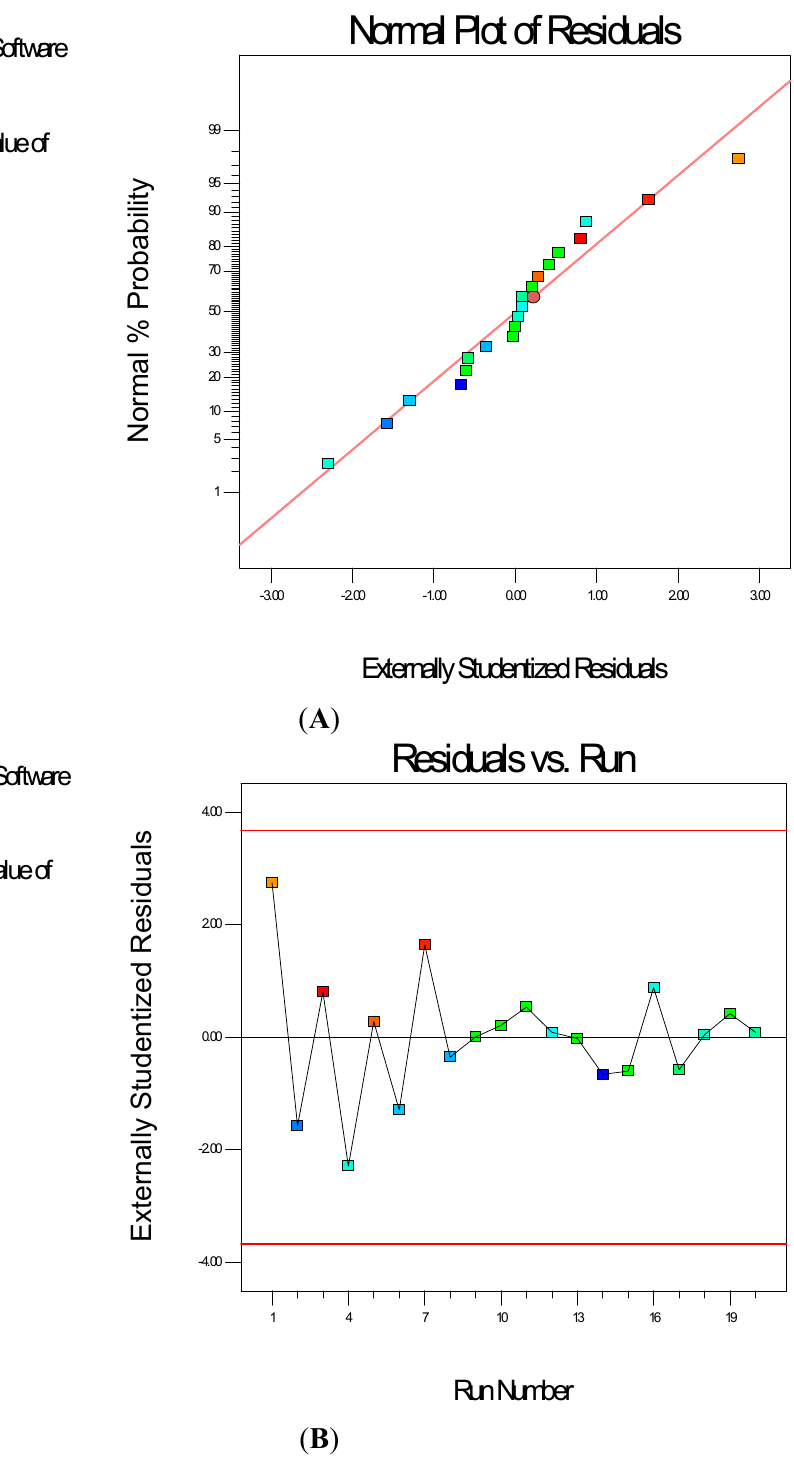
Figure 4. Diagnostic plots the percent yield data of Polylactide-based nanoparticles: ( A ) Normal Plot of Residuals; ( B ) Residuals vs. Run.